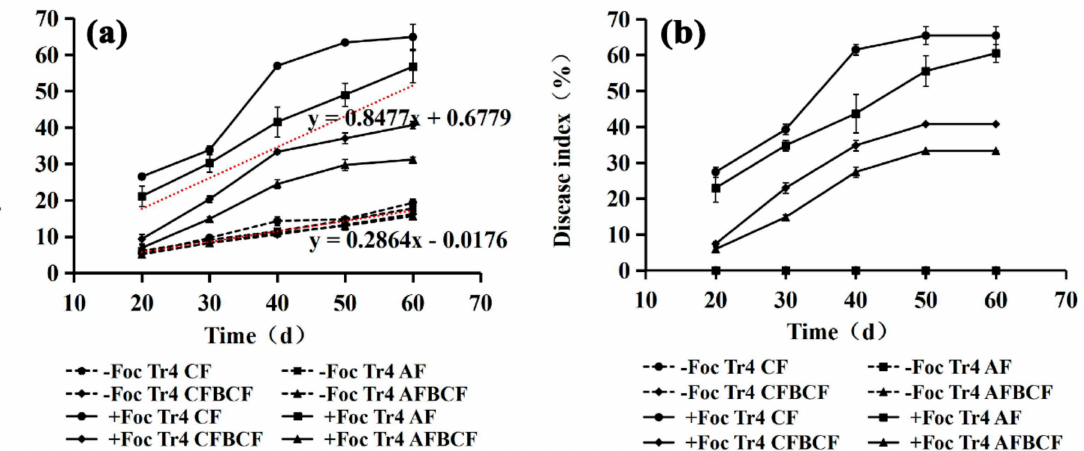
Figure 3. The effect of alkaline fertilizer and biocontrol fungi on incidence of yellow leaves (IYL) and disease index (DI) of banana plants. ( a ) Incidence of yellow leaves for each treatment; ( b ) Disease index for each treatment. The two equations are trend-line model of average value of IYL of four +Foc Tr4 treatments ( top ) and the that of four − Foc Tr4 treatments ( bottom ), respectively. CF stands for conventional fertilizer. AF stands for alkaline fertilizer. CFBCF stands for conventional fertilizer and biocontrol fungi. AFBCF stands for alkaline fertilizer and biocontrol